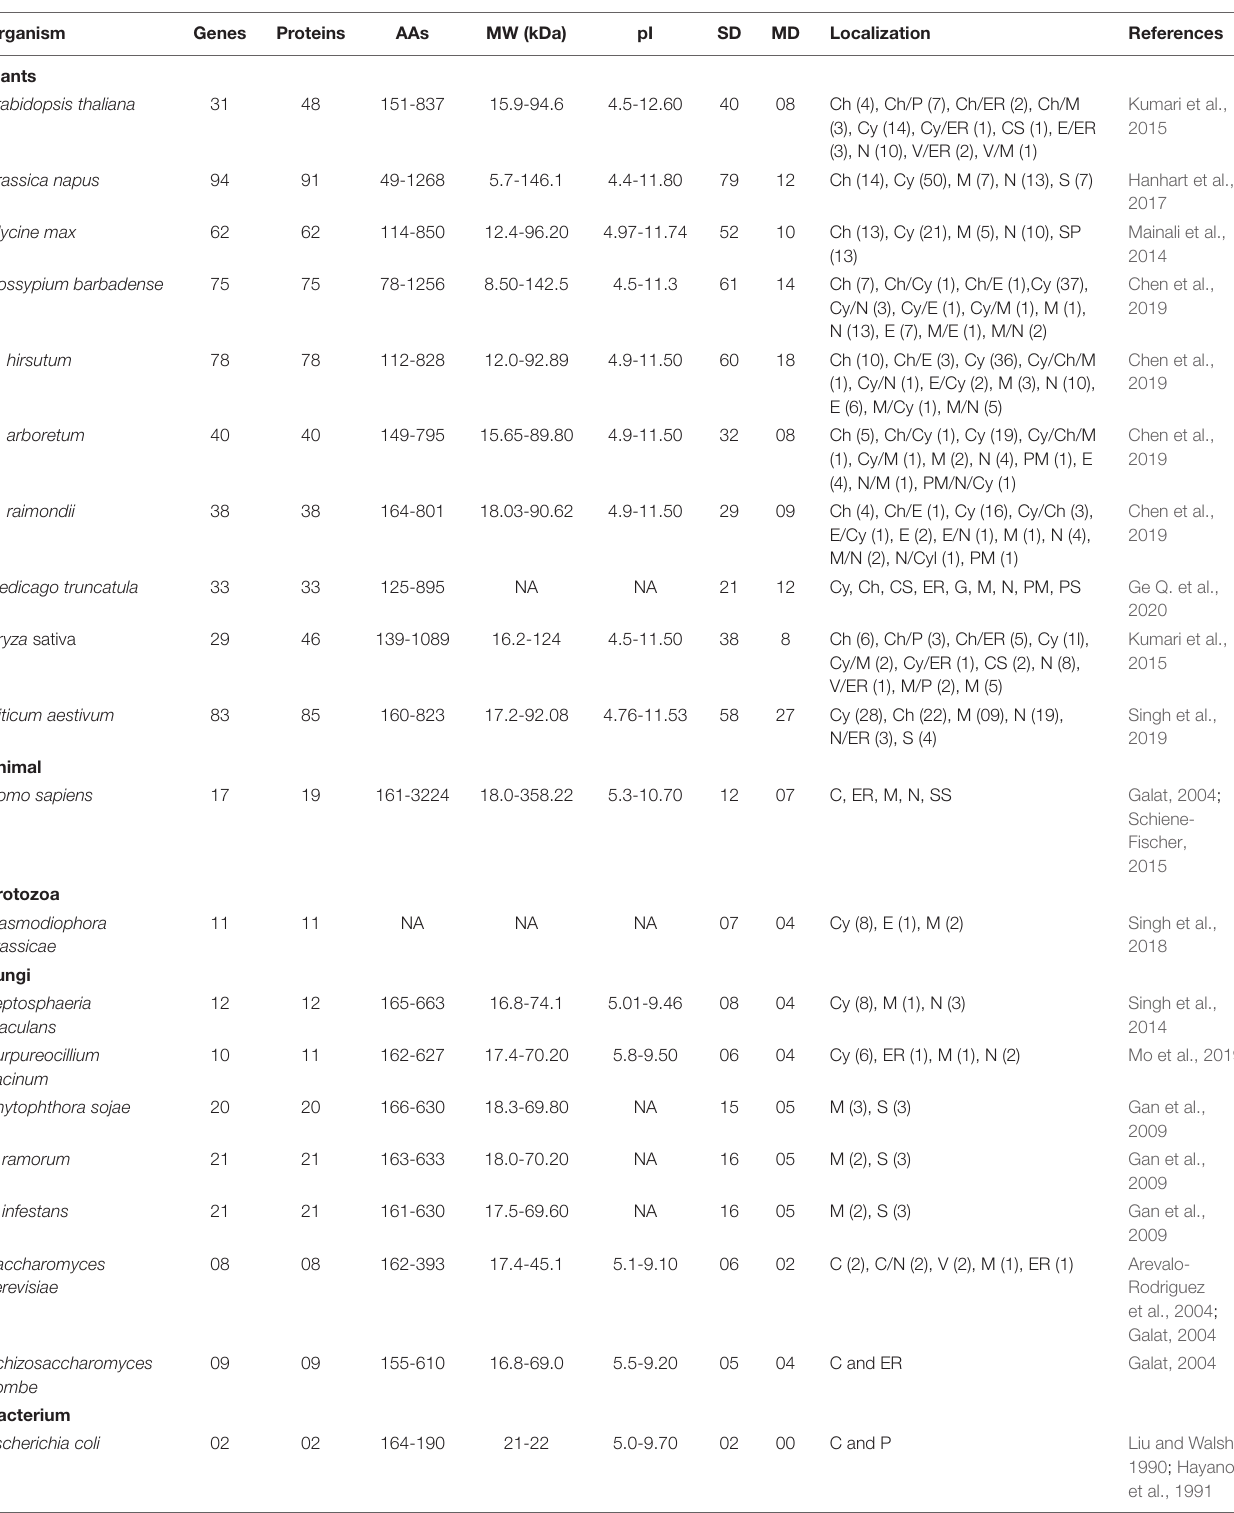
TABLE 1 | Genome-wide analysis of cyclophilins in different organisms. Organism Genes Proteins AAs MW (kDa)